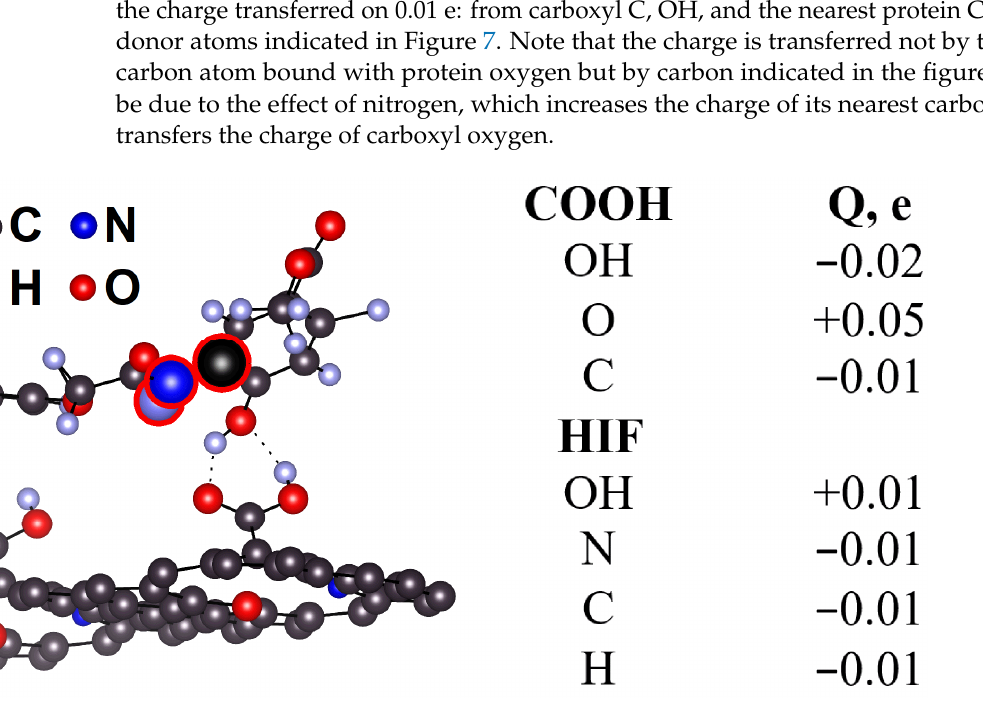
Figure 7. Transferred charge q between carboxyl and HIF-1 α .